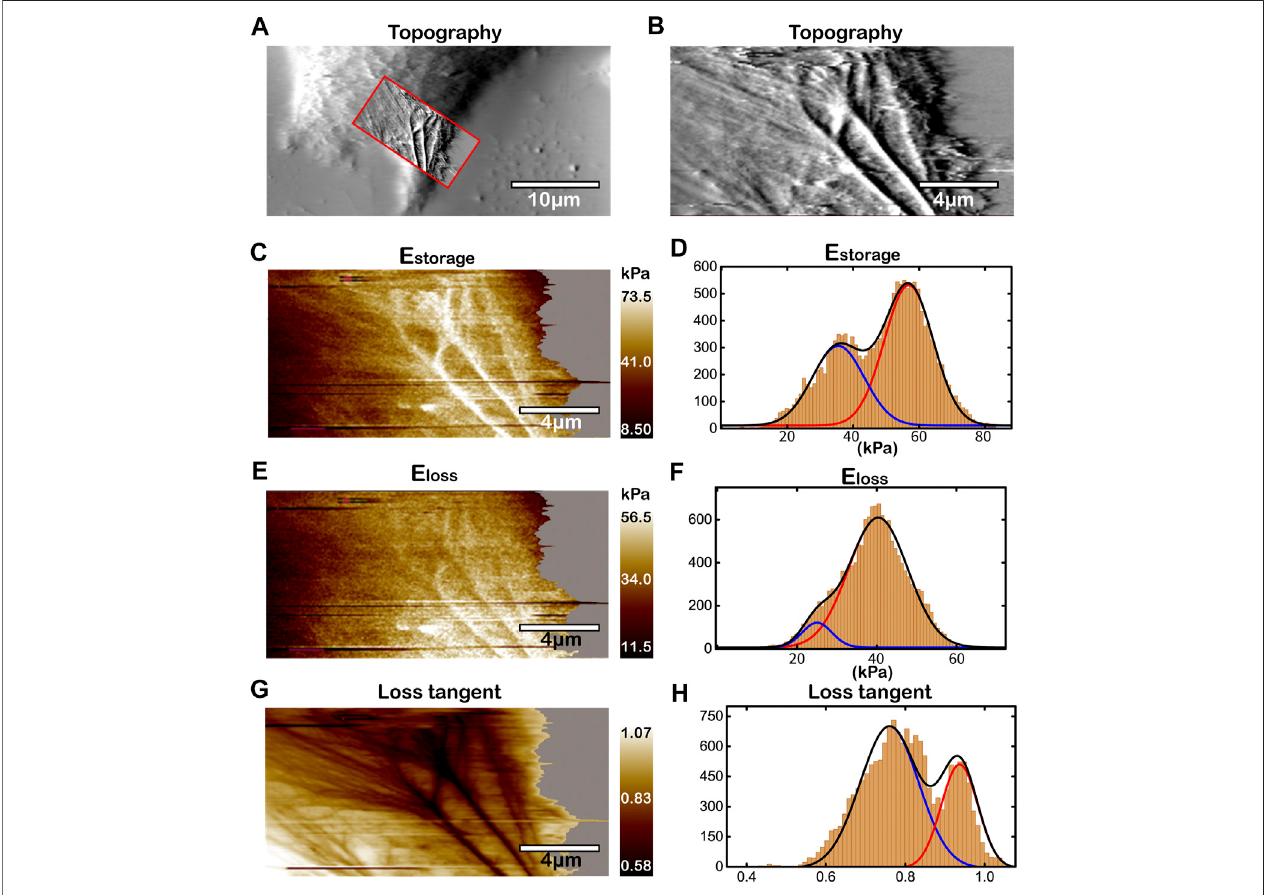
FIGURE5| TopographyandtheviscoelasticityofHuh-7cellsatpH6.5. (A) Topographyofcelledge. (B) High-resolutiontopographyoflamellipodiumregionwithin the red box in (A) . (C , E , G) Mapping of E storage (C) , E loss (E) , and loss tangent (G) simultaneously obtained byAM-FM AFM. (D , F , H) Histogram analysesof the measured E storage , E loss , and loss tangent in (C) , (E) and (G) , respectively.